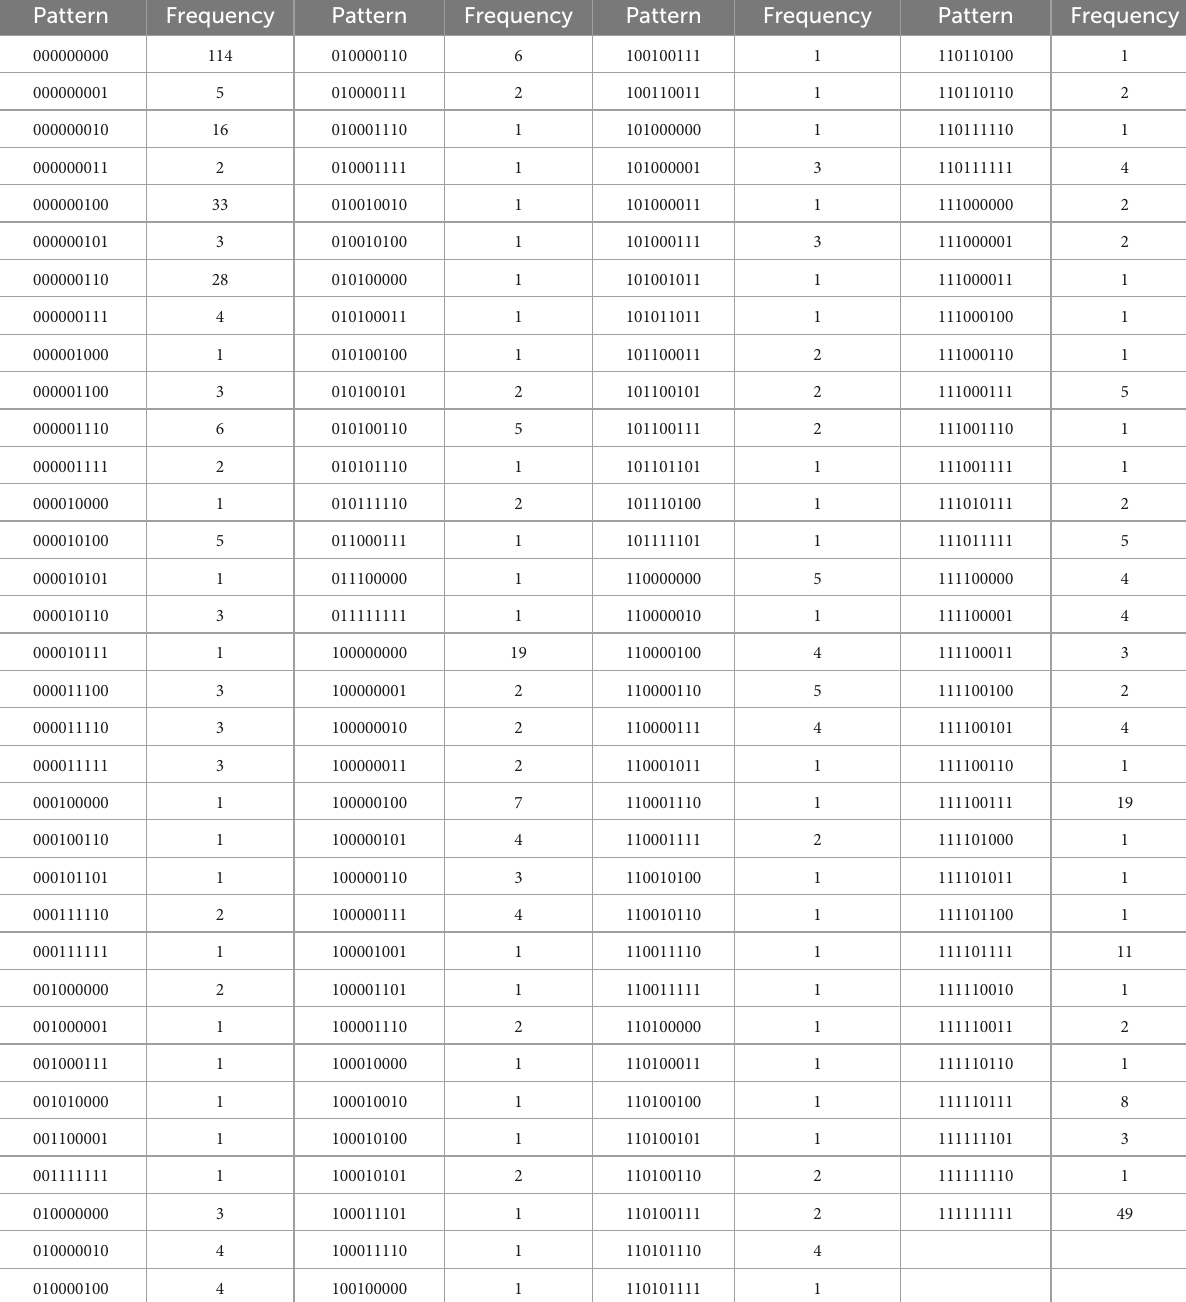
TABLE 4F Controlled motivation, with N = 550, k = 9 items, and u = 134 unique response patterns ( Appendix B ).